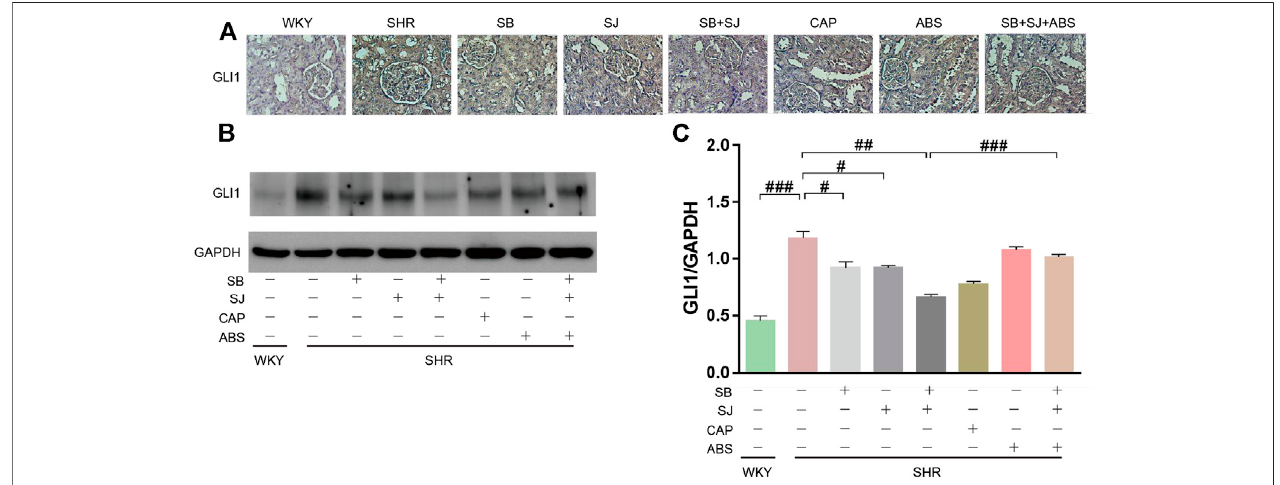
FIGURE 10 | (A) IHC staining of GLI1 (Magni fi cation, 40 × ). (B,C) Western blotting results of GLI1 and its quanti fi cation in kidneys. Data are presented as mean ± SD. ### p < 0.001. ## p < 0.01. # p <